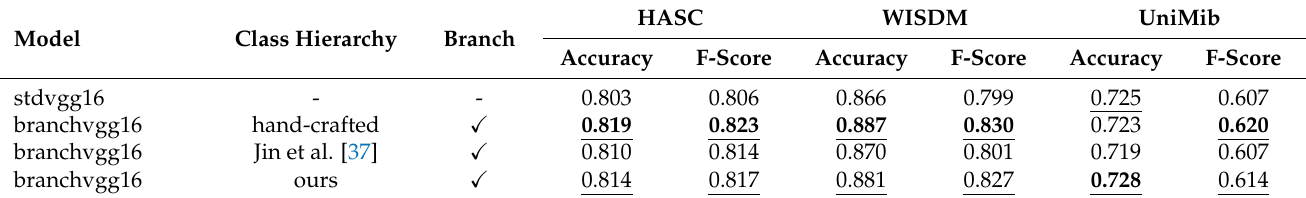
Table 2. Comparison of estimation accuracy for three types of activity recognition